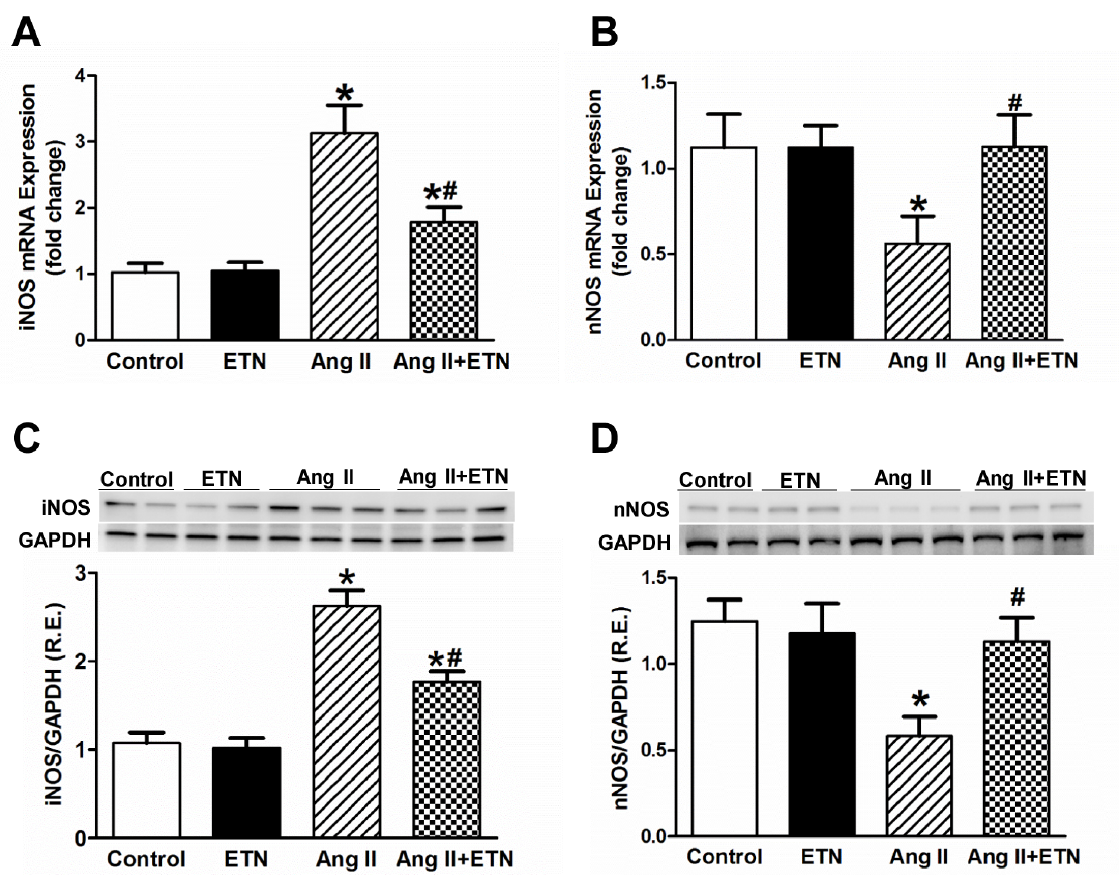
Figure 6. Effect of central TNF blockade on iNOS and nNOS mRNA and protein expression in the PVN. Ang II-infused rats demonstrated an increase in the mRNA and protein expression of iNOS, and decrease in expression of nNOS within the PVN. These alterations were reversed by TNF blockade with ICV etanercept treatment. R.E. Relative expression, n=8–12 per group, * p , 0.05 vs Control, # p , 0.05 vs Ang II.